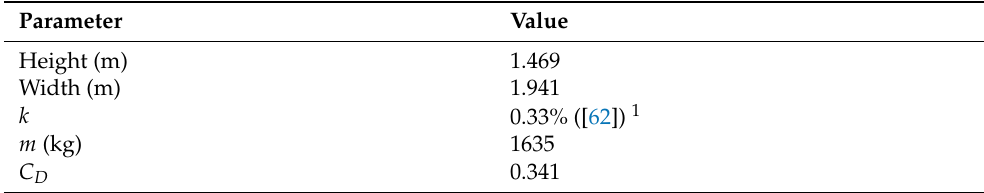
Table 5. Vehicle parameters (source [61])